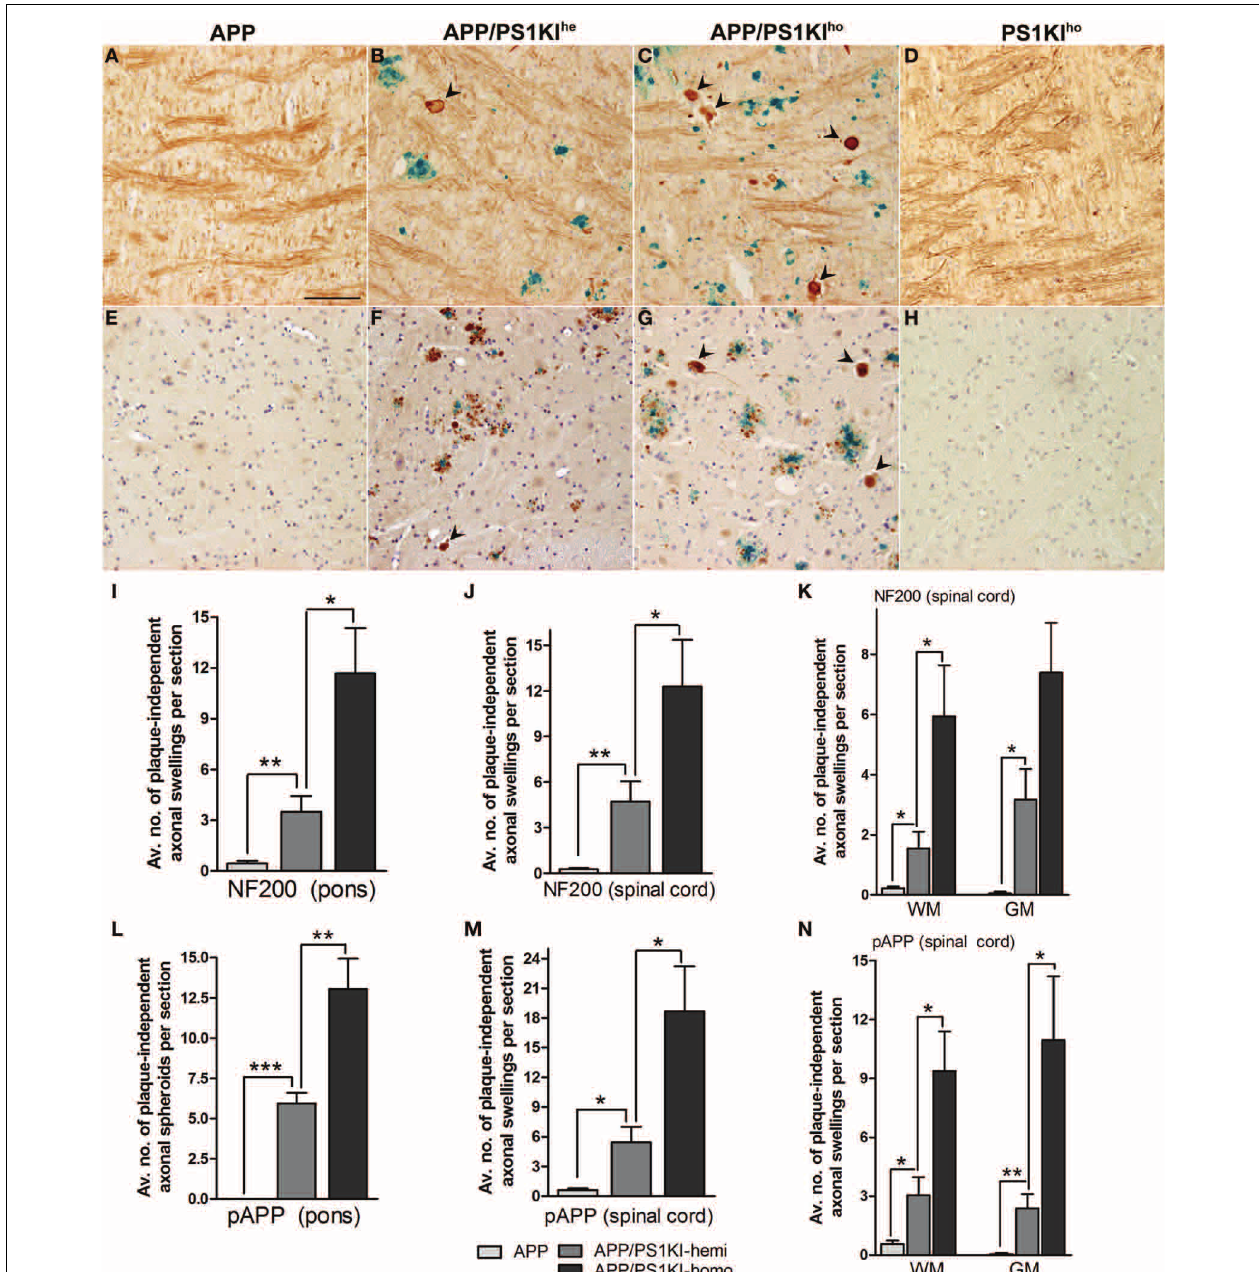
antibody in the pons (A–D) and anti-pT668 antibody in the spinal cord (E–H) . Increasing numbers of NF-200 (I–K) as well as pT668-positive (L–N) plaque-distant dystrophic fibers were found with increasing PS1 gene dosage in both pons and spinal cord with practically no dystrophic fibers in the APP mice. All error bars represent mean ± s.e.m. ∗∗∗ P < 0 . 001; ∗∗ P < 0 . 01; ∗ P < 0 . 05. Scale bar: 100 μ